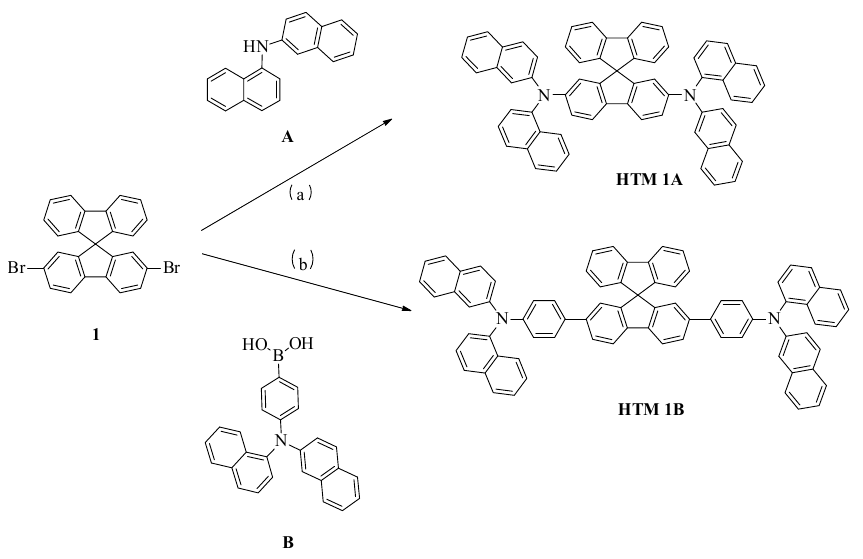
Scheme 1. Synthesis of HTMs 1A and 1B . Reagents and Conditions : ( a ) Pd(OAc) 2 , NaOtBu, t -Bu 3 P, anhydrous toluene, 105 ° C; ( b ) Pd(Ph 3 P) 4 , 2 M K 2 CO 3 , toluene, 110 ° C. Table 1. Thermal and photophysical properties of HTMs 1A , 1B and Spiro-NPB.